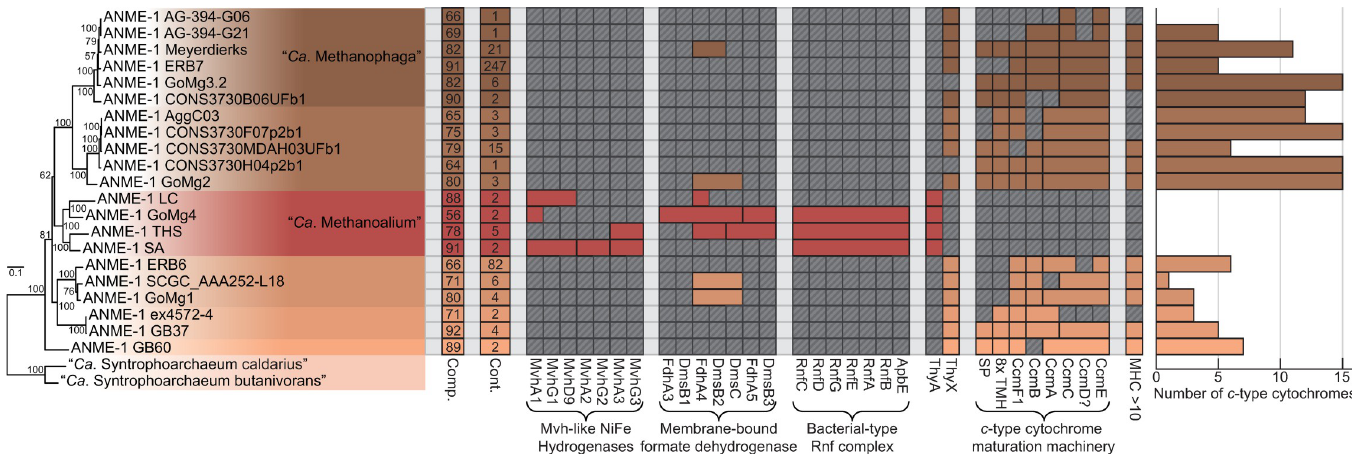
Fig 18. Comparison between “ Ca . Methanoalium” and other ANME-1 genera. Phylogenomic tree based on concatenated marker proteins highlighting individual ANME-1 genera, 2 of which have been assigned “ Candidatus ” names. Estimated genome completeness and contamination are shown in the first and second columns. Comparison of the presence of hydrogenase, membrane-associated formate dehydrogenases, Rnf complexes, and cytochrome maturation machinery highlights important differences in electron flow between these genera. Genomes encoding MHC with more than 10 CxxCH heme-binding motifs are marked in the final column. Bar chart on the far right demonstrates the number of c -type cytochromes per genome. Only branch support values > 50% are shown for clarity. Tree scales represent substitutions per site. Tree construction parameters are found in the Materials and methods section. Alignment and tree files can be found in S1 Data , and gene accession numbers can be found in S2 Data . ANME, anaerobic methanotrophic; MHC, multiheme c -type cytochrome; Rnf, Rhodobacter nitrogen fixation.